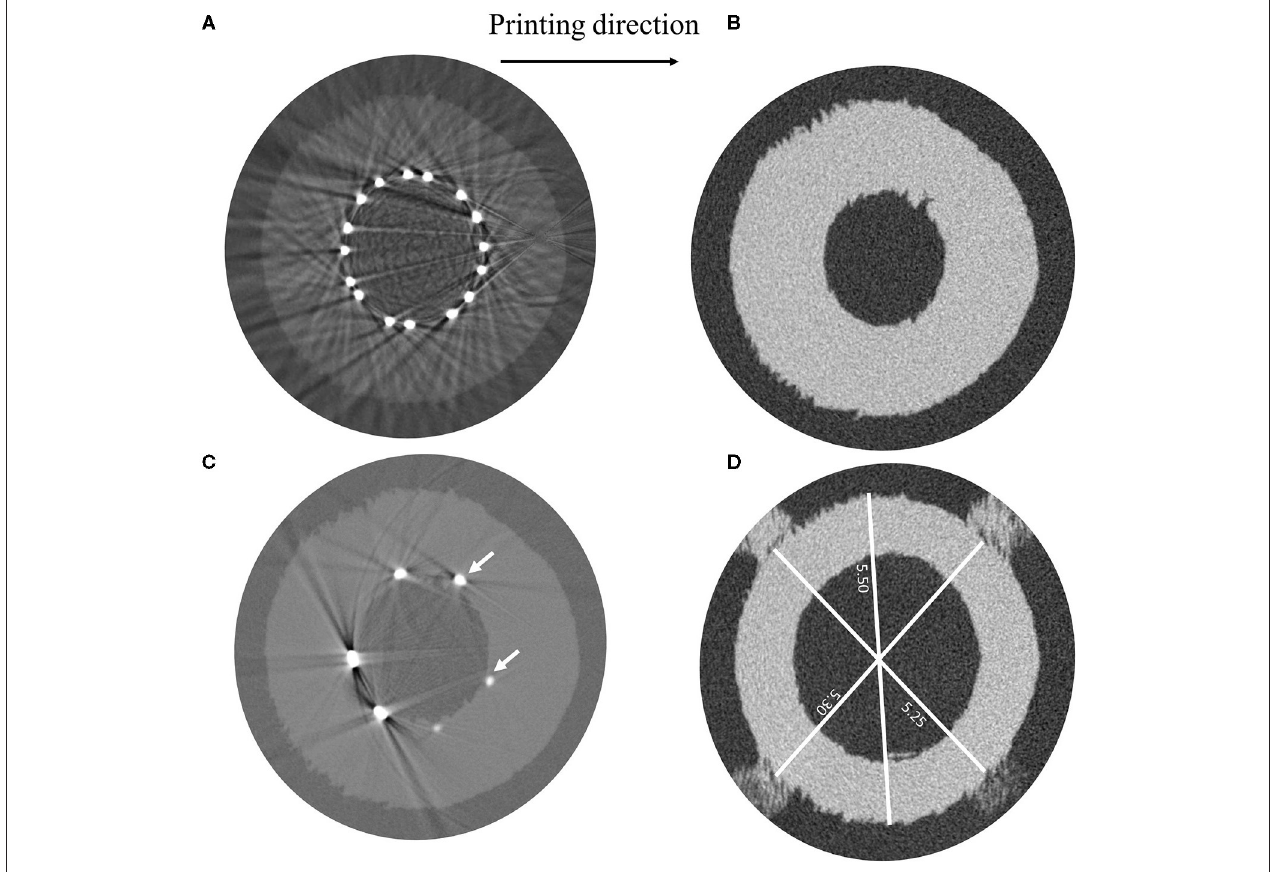
FIGURE 7 | µ CT images showing (A) irregularities in the vessel geometry ascribable to the 3D-printing process, (B) measurements of different vessel diameters, (C) light beams reflected by the SYNERGY TM stent during the acquisition preventing the evaluation of the struts’ malapposition, and (D) detail of struts indenting the vessel wall. Indication about the printing direction is provided.